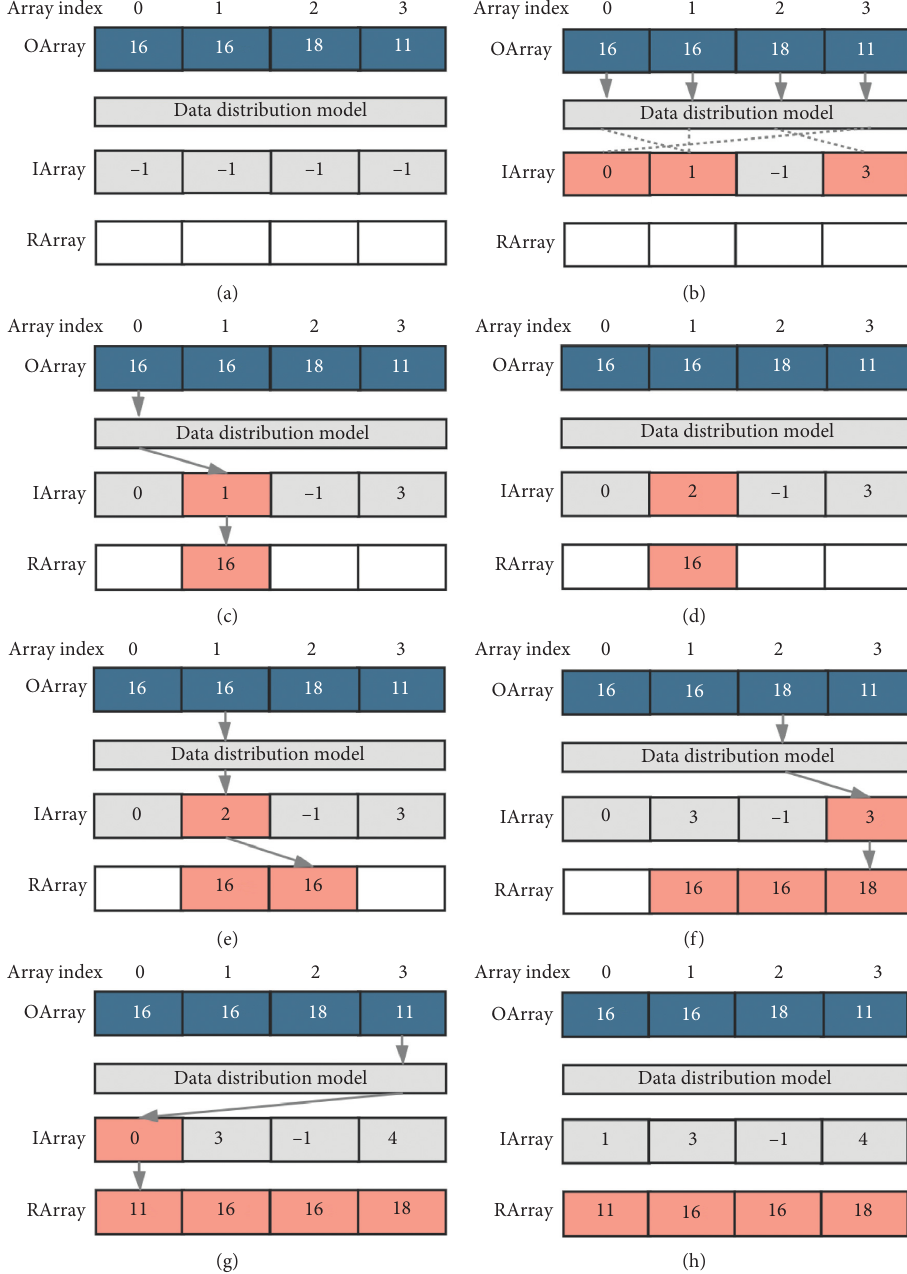
Figure 7: Illustration of the proposed placement solution. The array elements highlighted in pink show the changes during the